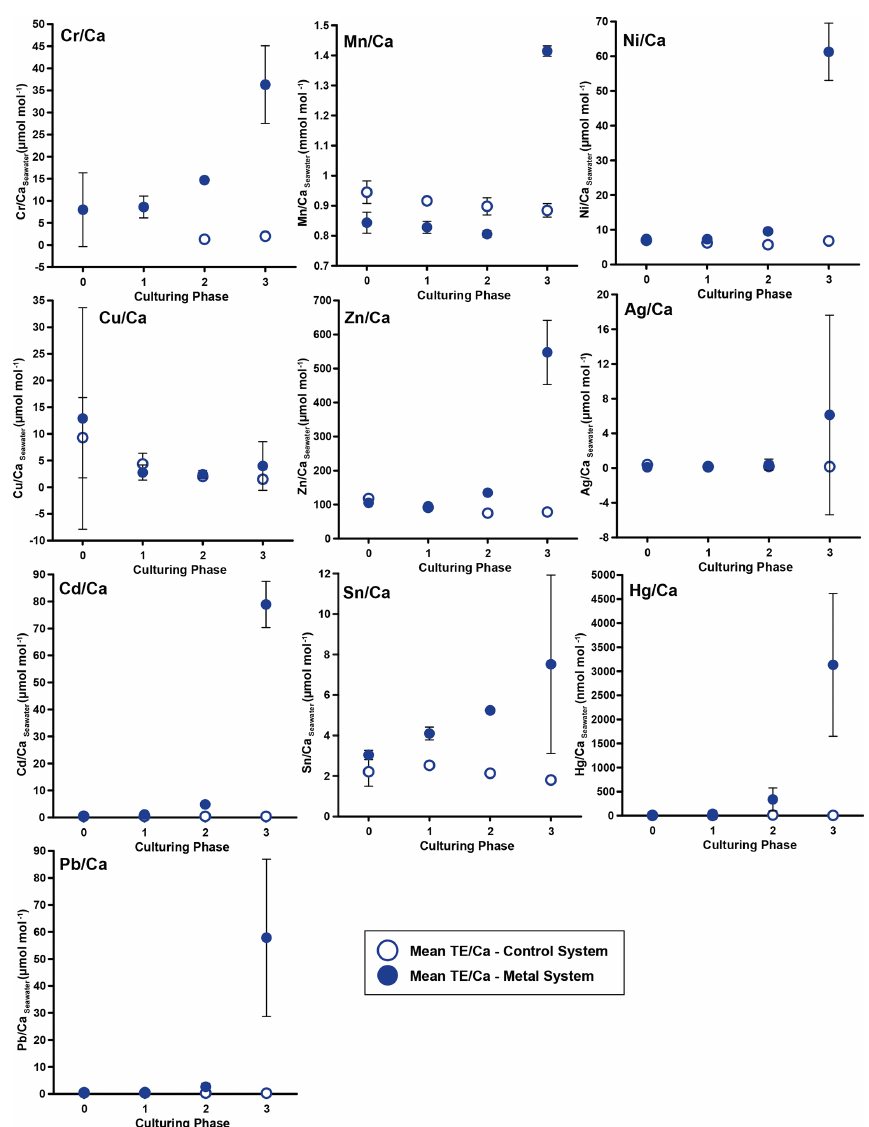
Figure 3. Weighted mean TE / Ca values in the culturing medium in µmolmol − 1 . Error bars display the standard deviation of the mean. Open symbols represent the control system, where no extra metals were added during the complete culturing period (phase 0 to 3), and closed symbols represent the metal system. In this system, phase 0 is the control phase without any extra added metals, and for phase 1 to 3, the heavy metal concentration in the culturing medium was elevated. Note that the standard deviation is comparably high in phase 3 because the heavy metal concentration in this phase varied more strongly, which is shown in the Appendix (Table A1, Fig. B1). Therefore, this error is derived from the real values in the seawater and not from analytical uncertainties. Note that the Cr / Ca values from the control system in phase 0 and 1 are not given as these values were below the detection